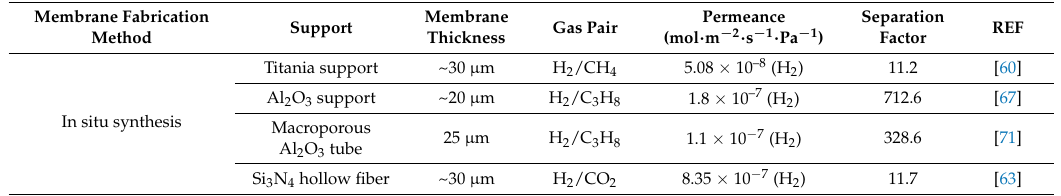
Table 1. Summary of membrane properties of representative ZIF membranes prepared by different